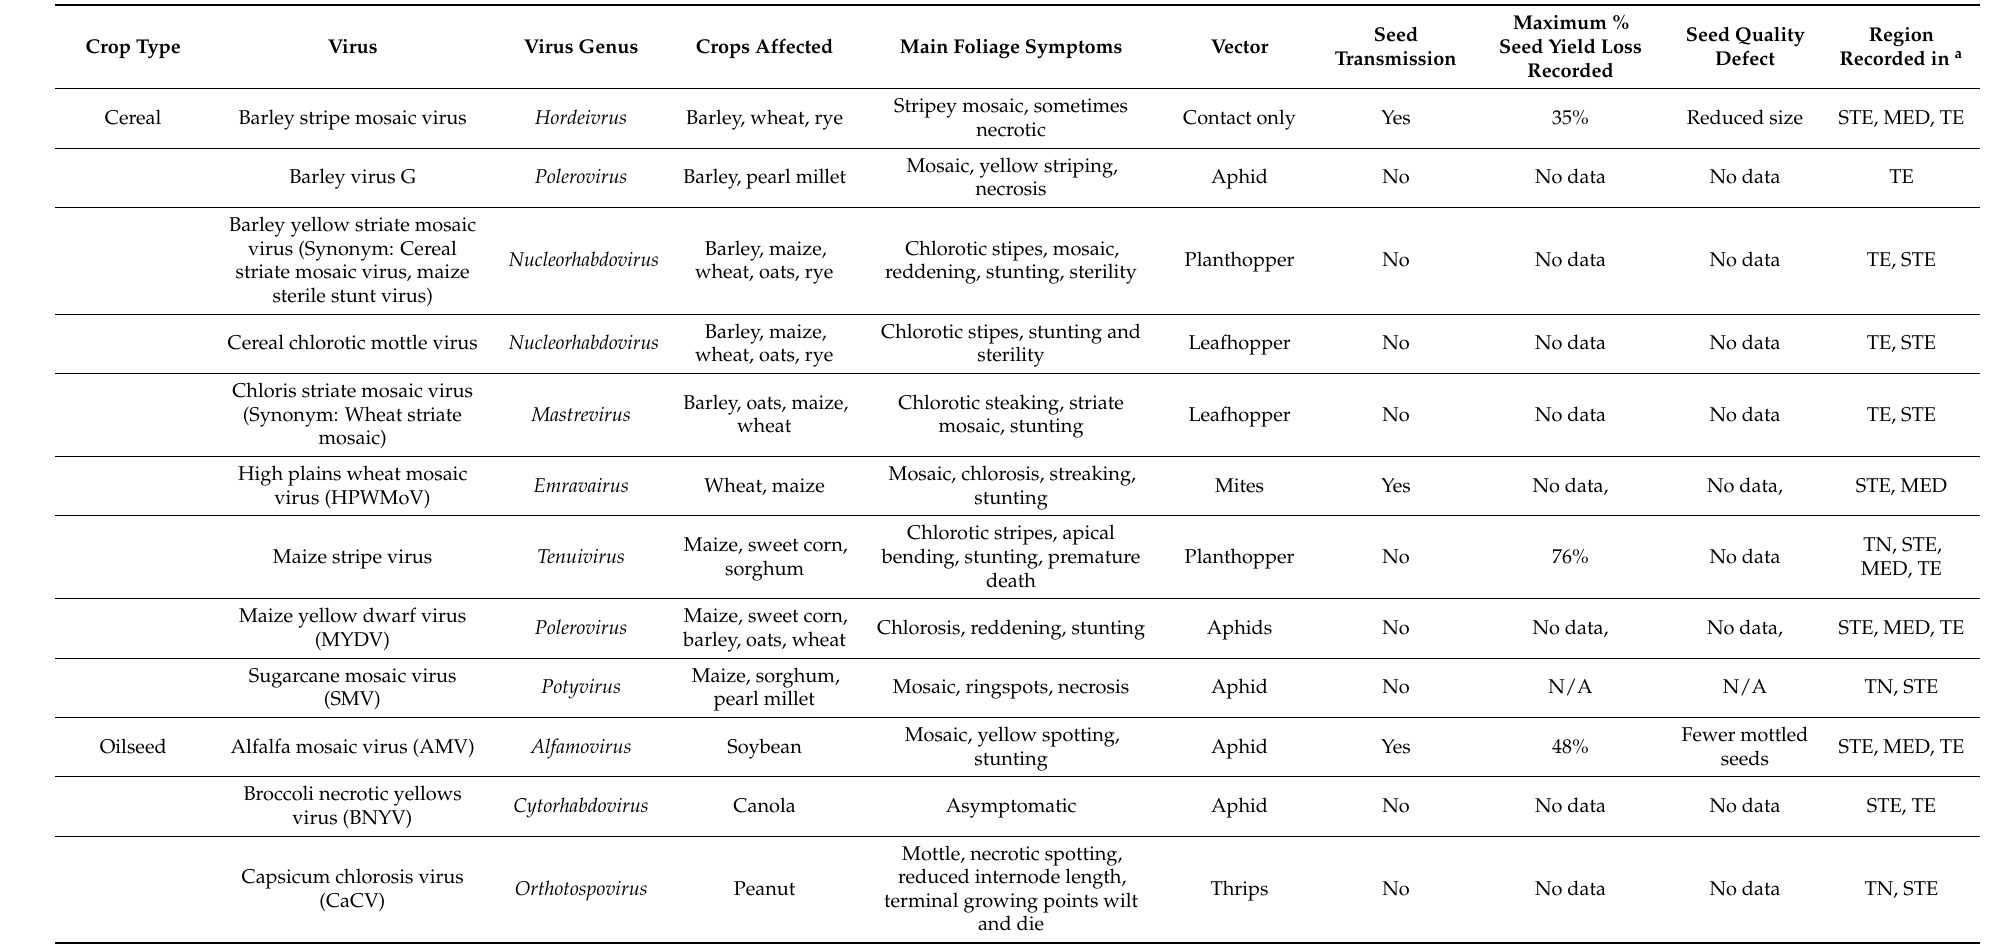
Table 3. Other viruses that infect cereal and oilseed crops in